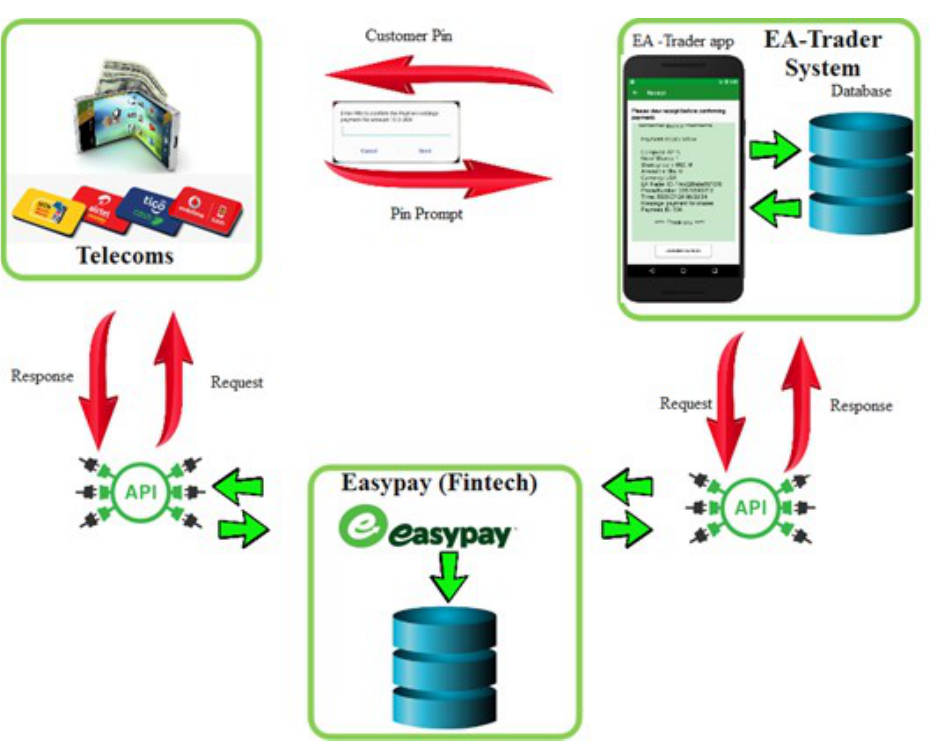
Figure 2. User Profile on EA-Trader